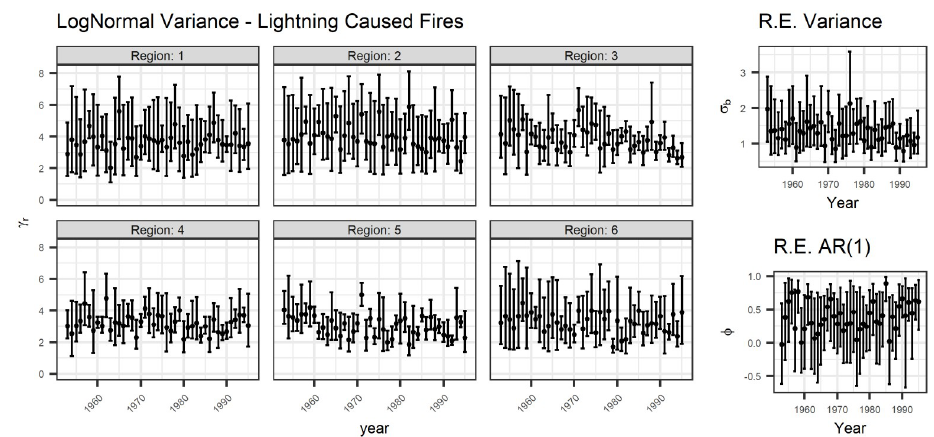
Fig 7. The variance parameters for lightning-caused fires. There is no apparent trend over time, except perhaps a slight decrease in region 5 and in the random effect variance, with an increase in the AR(1) parameter. The AR(1) parameter is constrained to be in the interval [-1,1].